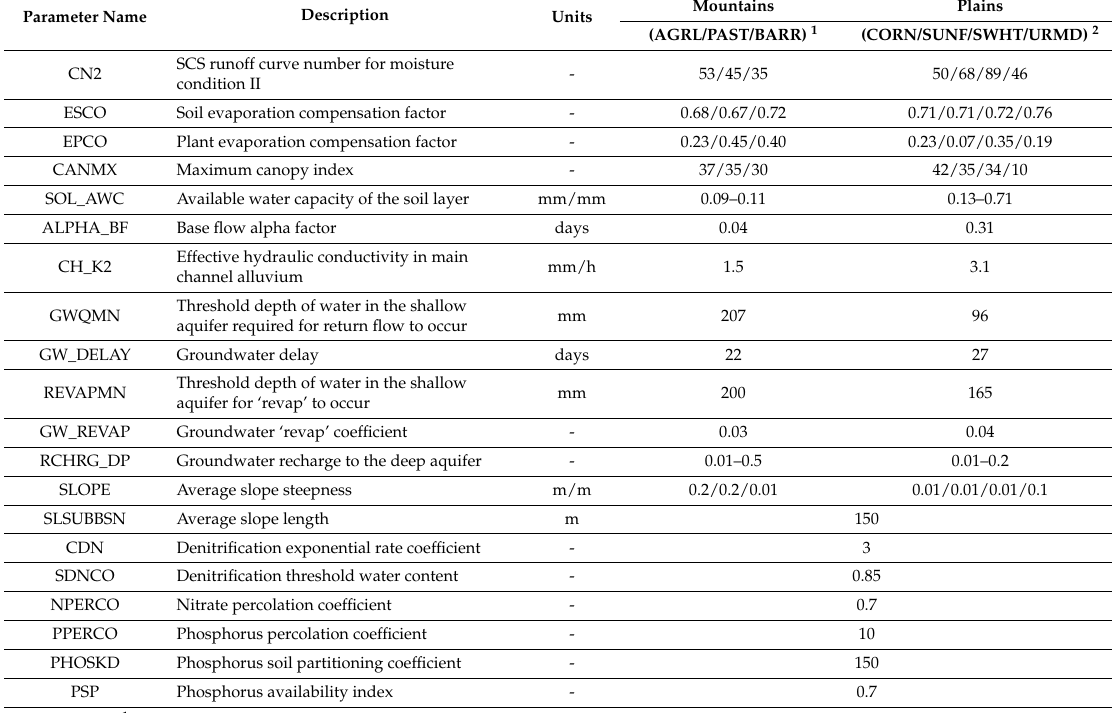
Table 1. Main variables used for sensitivity analysis and calibration in SWAT and the final calibrated